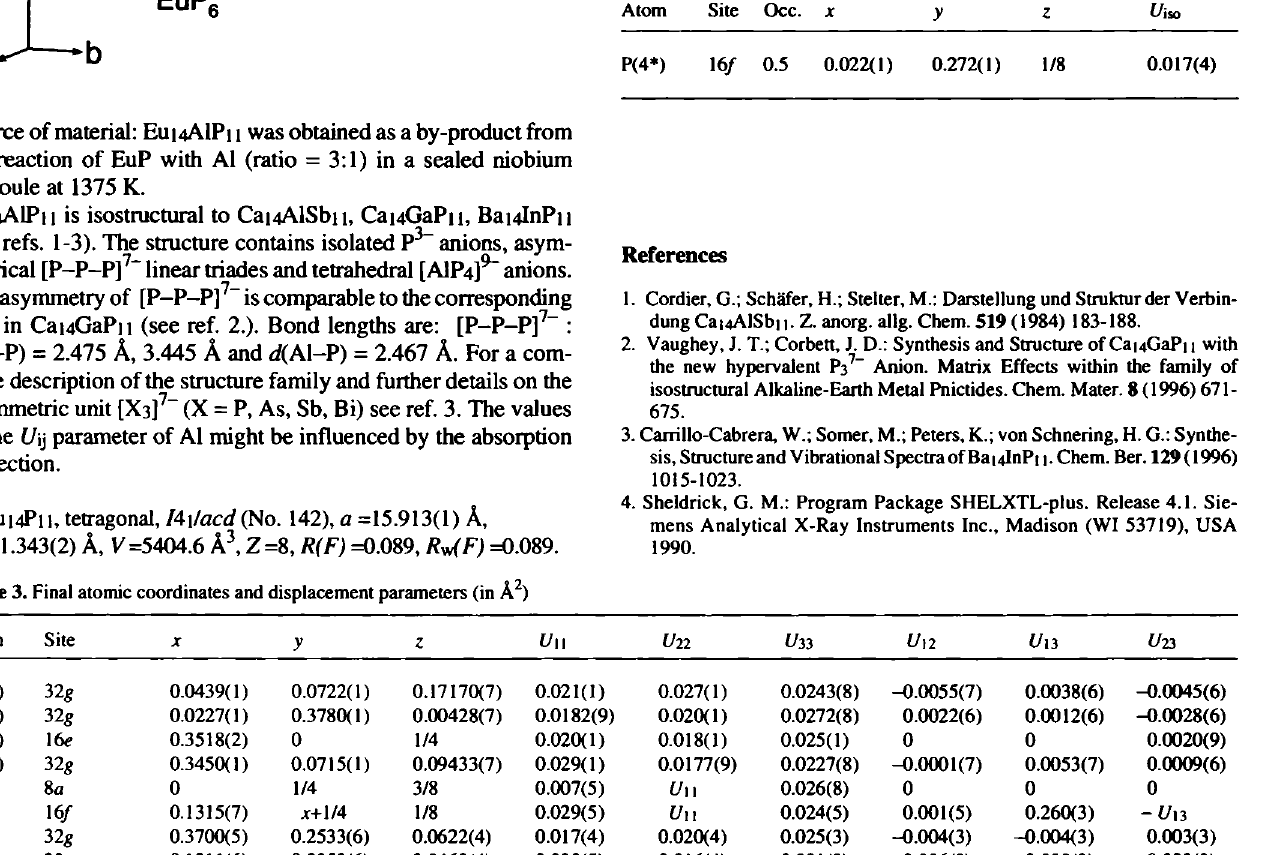
Table 2. Fmal atomic coordinates and displacement parameters (in